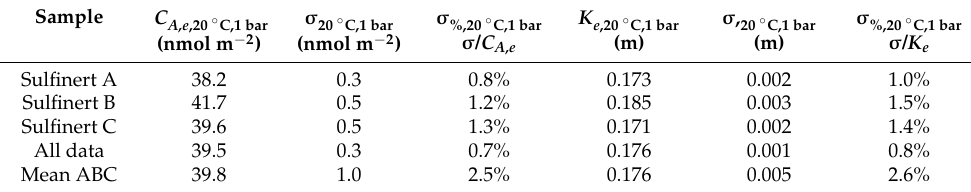
Table 5. Sulfinert ® specific amount adsorbed ( C A,e ) and equilibrium constant ( K e ). Data were corrected at 20 ◦ C 1 bar. Reproducibility as the experimental standard deviation of the mean of corrected data. Single Sulfinert ® samples A, B, C, all data sets in one and calculated from the